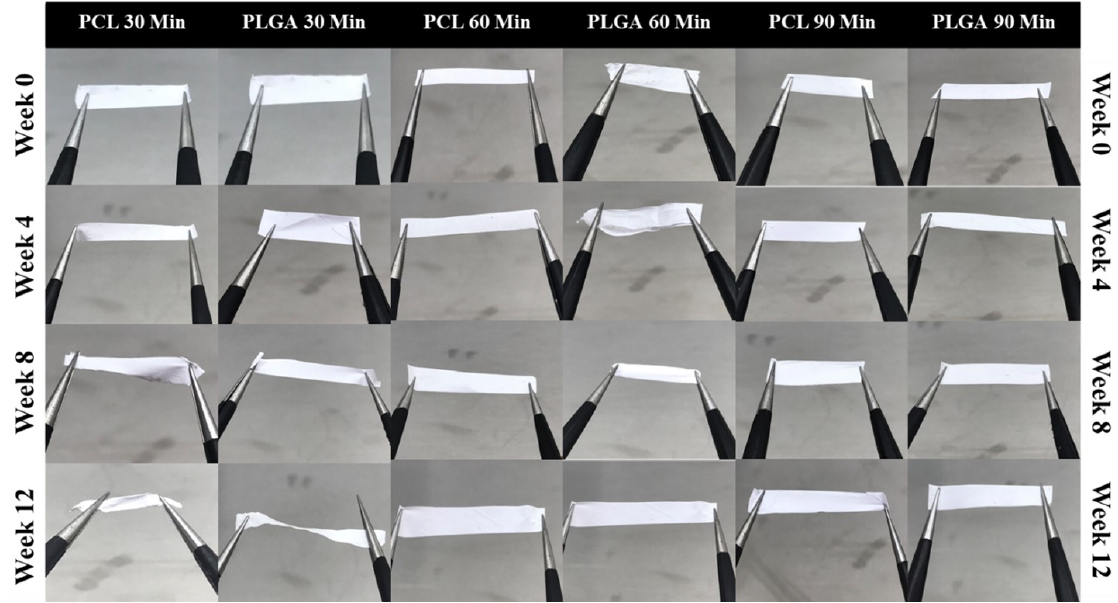
Figure 8. Handleability images of 30-, 60- and 90-min PCL and PLGA scaffolds over a 12-week period.